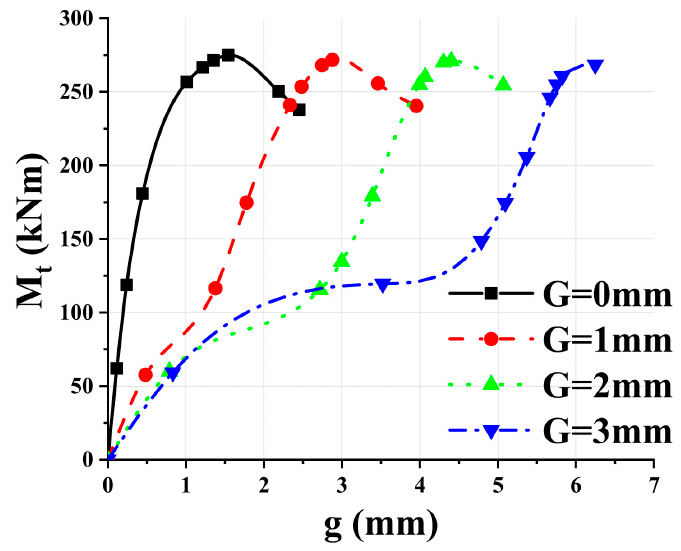
Figure 22. Moment-relative dislocation curves of connections with different construction errors. Rotation difference-moment curves of the G0 to G3 models were shown in Figure 23.